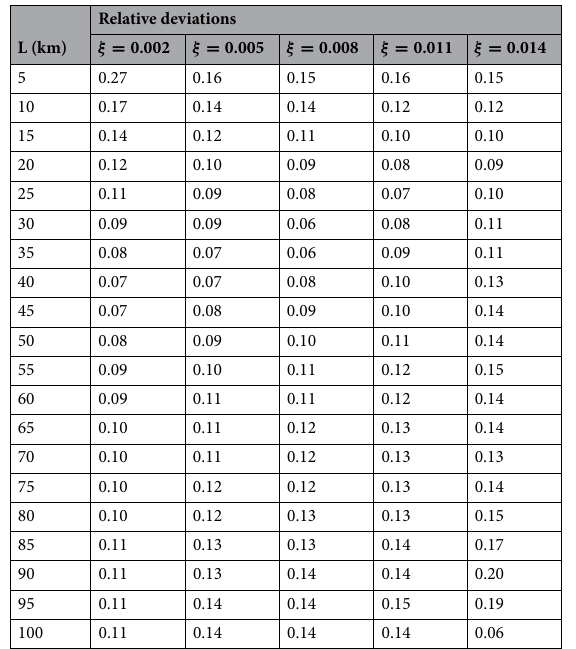
Table 1. Relative deviations between key rates predicted by our neural network and the corresponding key rates obtained by the numerical method for the given optimal light intensity at different distances and different excess noises.